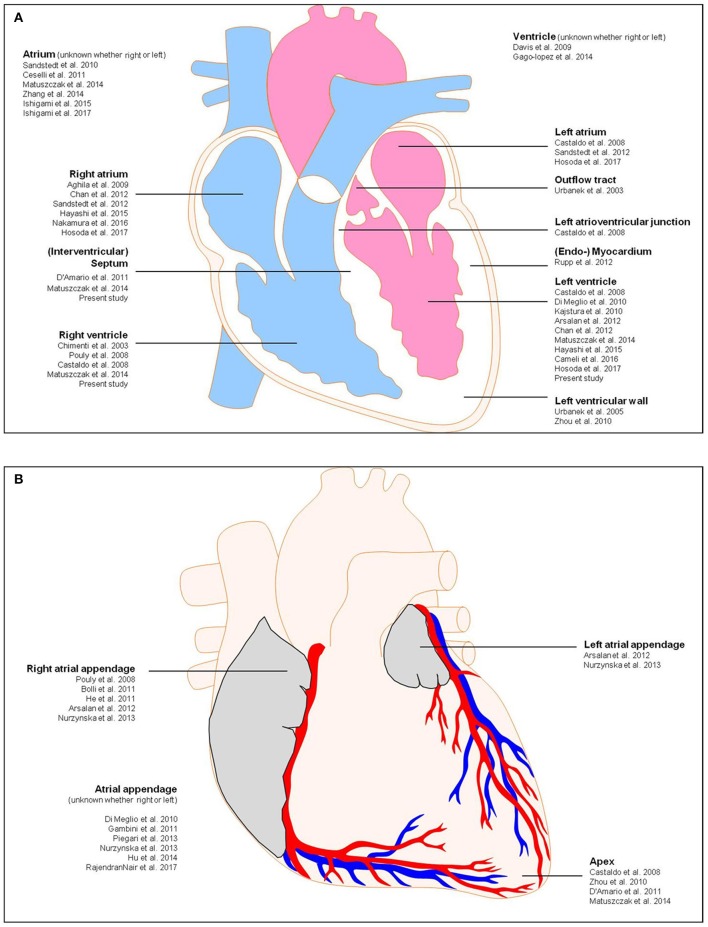
Schematic representation of the human heart showing biopsy locations used for previous identifications of CD117 and CD90. (A) Anterior view, (B) frontal section. Detailed information about the previous studies is shown in Table 1.